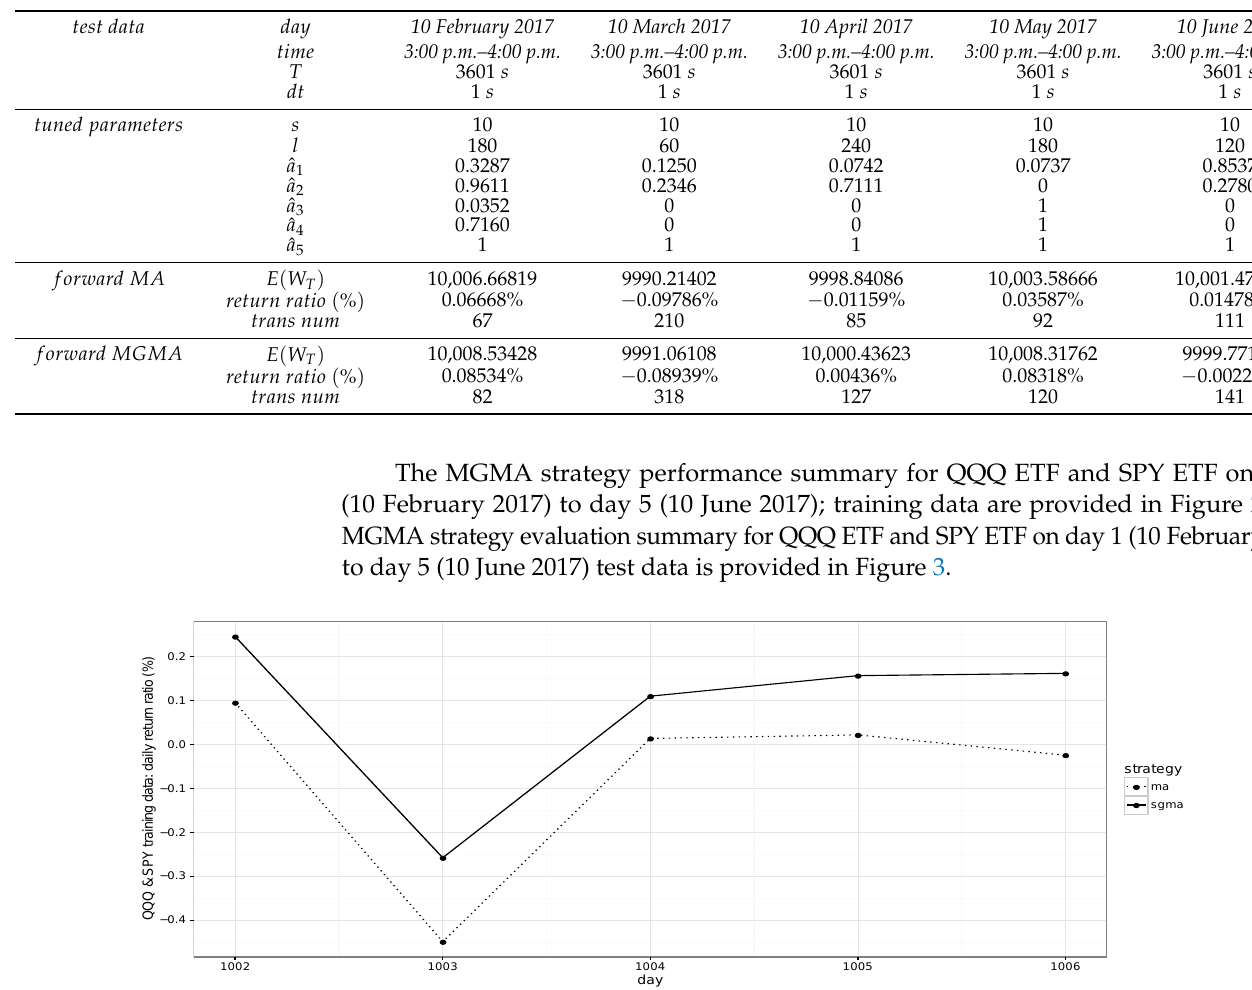
Figure 2. Case 1—MGMA strategy performance summary plot for QQQ ETF and SPY ETF on day 1 (10 February 2017) to day 5 (10 June 2017) training